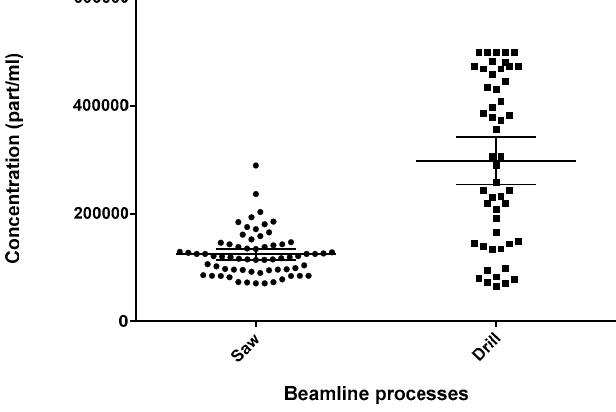
Figure 6. Beamline processes grab sample distribution; saw ( n = 66) and drill ( n = 50).